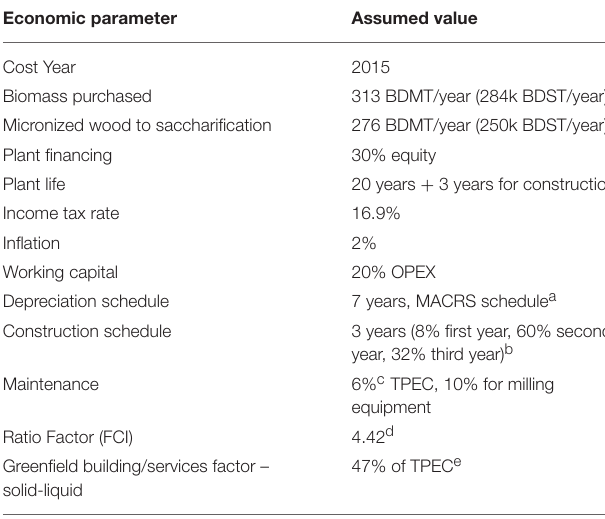
TABLE 1 | Assumed economic parameters for base case